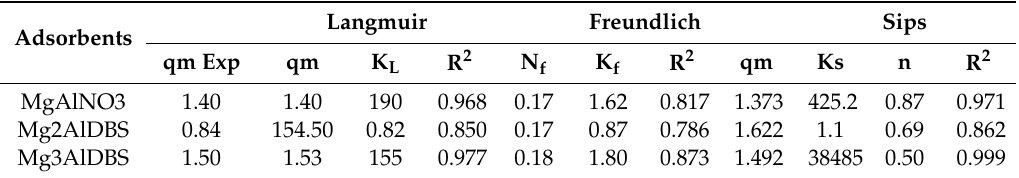
Table 7. Parameters of Langmuir, Freundlich and Sips isothermal models of BG adsorption by MgAlNO3, Mg2AlDBS and Mg3AlDB.